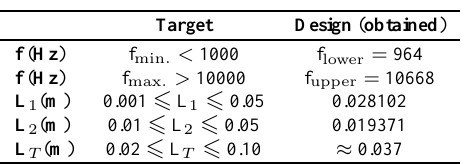
Table 4 Target and design values for example 4